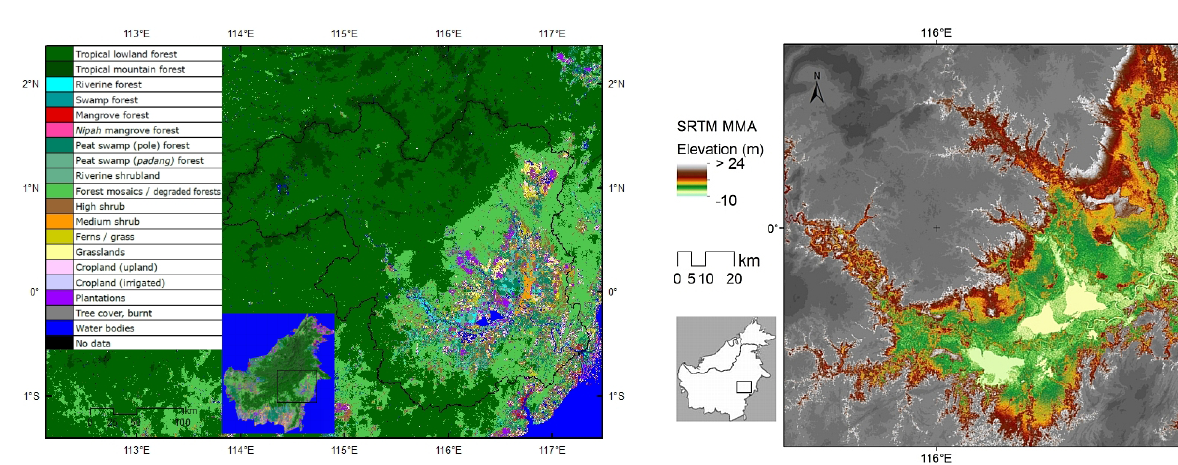
Fig. 2. Study area in East Kalimantan with a colour coded SRTM digital elevation model for the middle Mahakam lowland